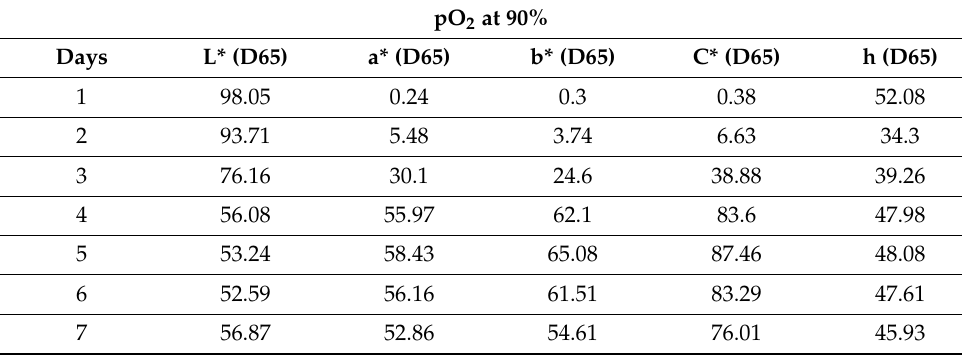
Table 6. Colorimetric (D65) values L*a*b*c*h of extracellular extracts from 2 L bioreactor fermentation with pO 2 at